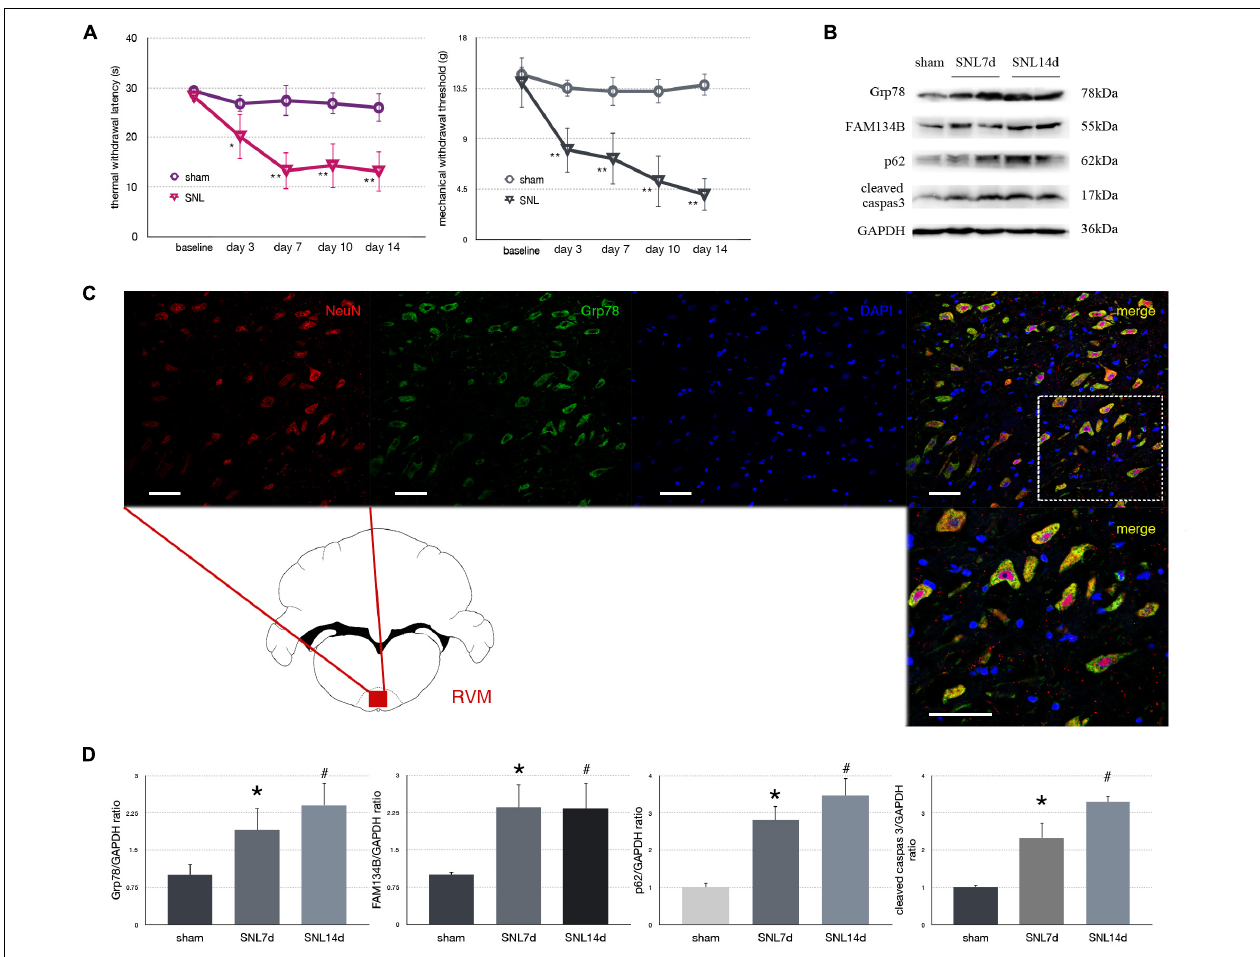
FIGURE 2 | Effect of SNL on behavior tests, protein expression in spinal cord, and immunofluorescence staining in RVM (rostral ventromedial medulla). (A) TWL (thermal withdraw latency) and MWT (mechanical withdraw threshold) were used to evaluate the thermal and mechanical hyperalgesia in SNL rats. * p < 0.05 vs. sham group. (B) Western blot analysis of Grp78, FAM134B, p62, cleaved caspase-3 in the spinal cord of sham, SNL7d (SNL postoperative 7 days), and SNL14d group (SNL postoperative 14 days). GAPDH is used as an endogenous control. (C) Representative double immunofluorescence images of Grp78 (green) and